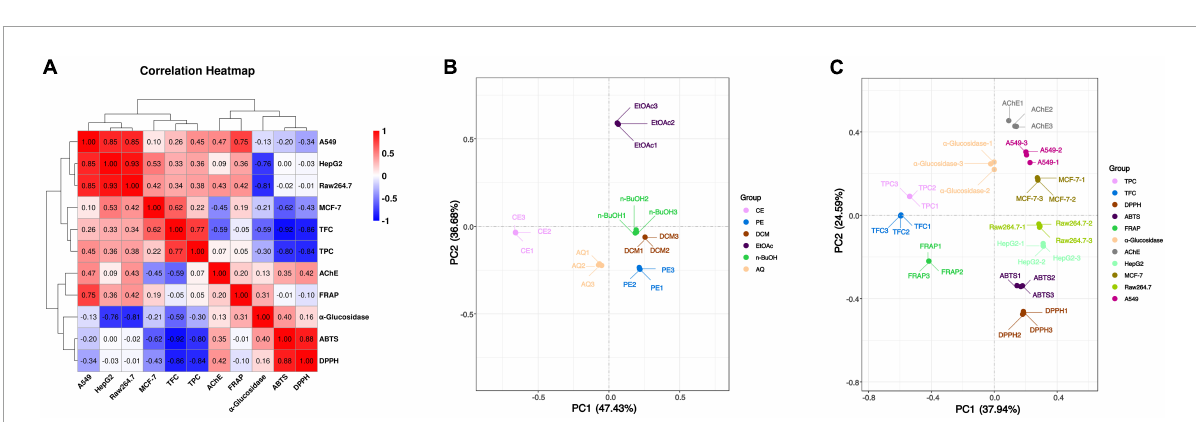
FIGURE2 Heatmap graph of correlation analysis and principal co-ordinates analysis of BCF crude extract and its fractions. (A) Heatmap graph of correlation analysis, P -value (ranging from –1 to 1) and corresponding color (blue to red) represented the magnitude of the spearman correlation coefficient (r) in the heatmap; (B) PCoA of BCF extract and its fractions; (C) PCoA of active ingredient content and biological activity of BCF extract and its